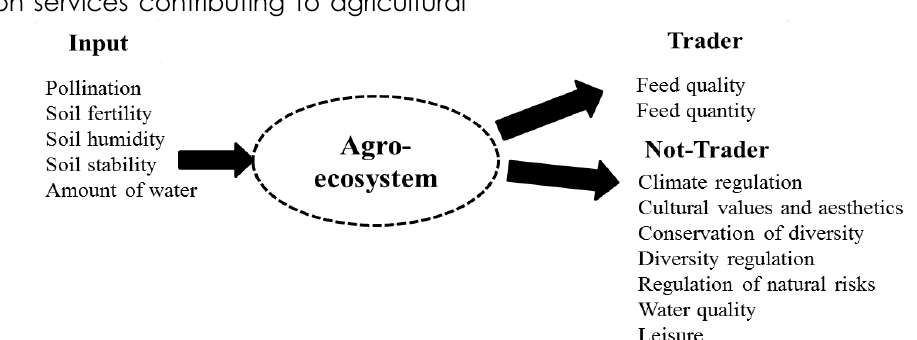
Fig. 4. Conceptual diagram of the services organization for an agro-ecosystem (Lamarque, 2012).